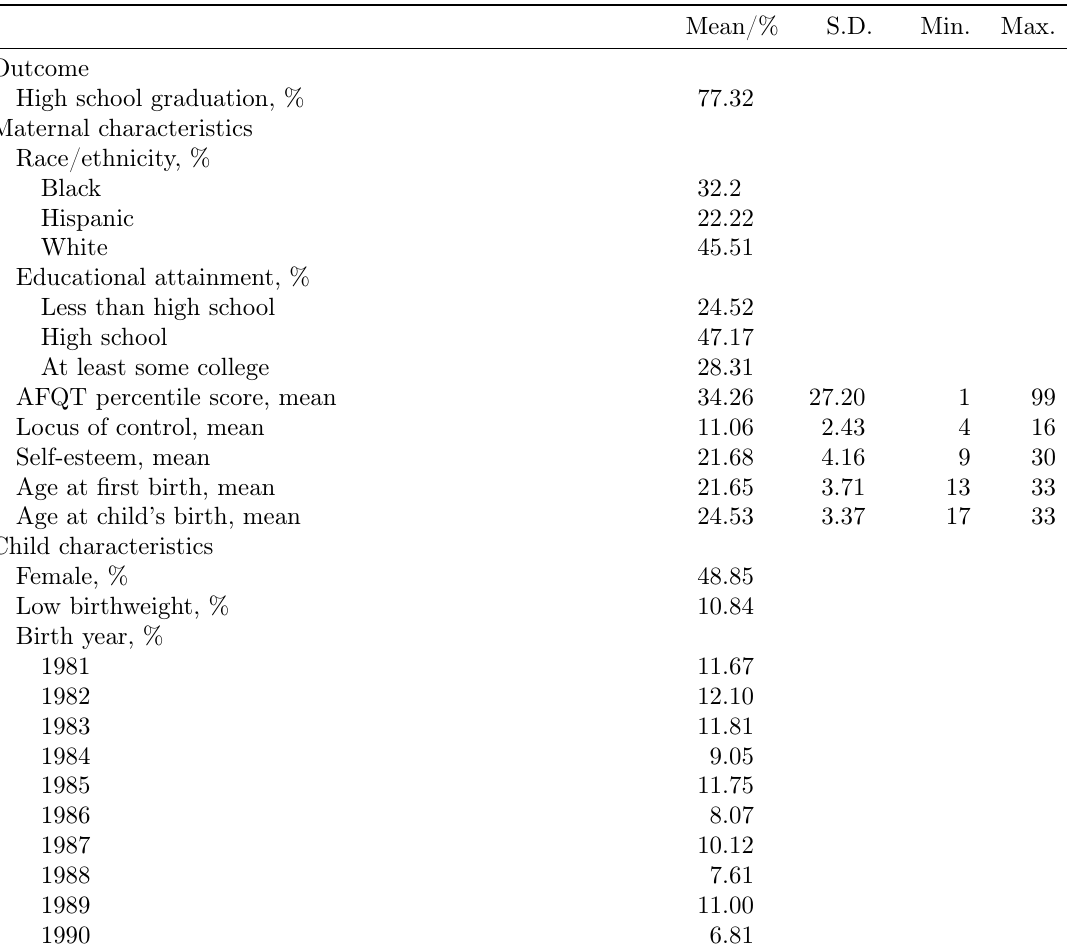
Table 1: Descriptive Statistics for Age-Constant Characteristics ( N = 3 , 744 )